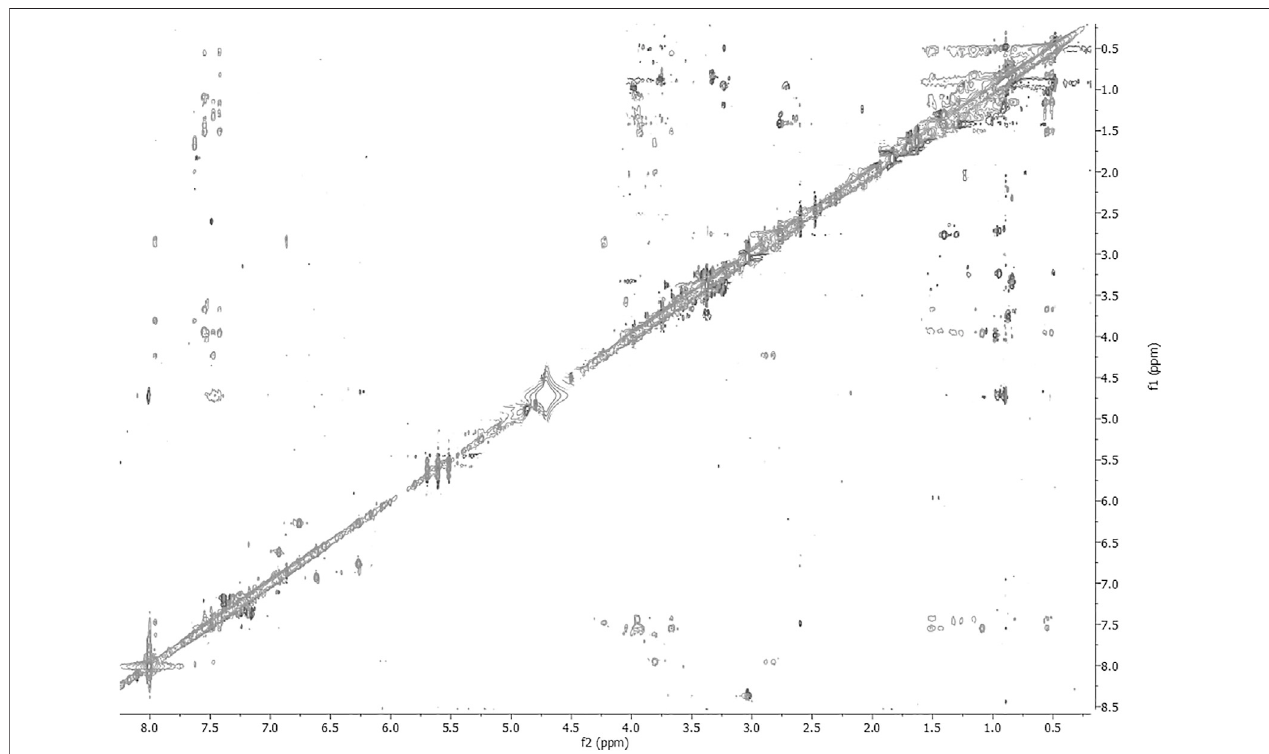
FIGURE 5 | 2D-NOESY spectrum of 3 HFA/H 2 O solution (600 MHz, 300 K, t mix (cid:2) 400